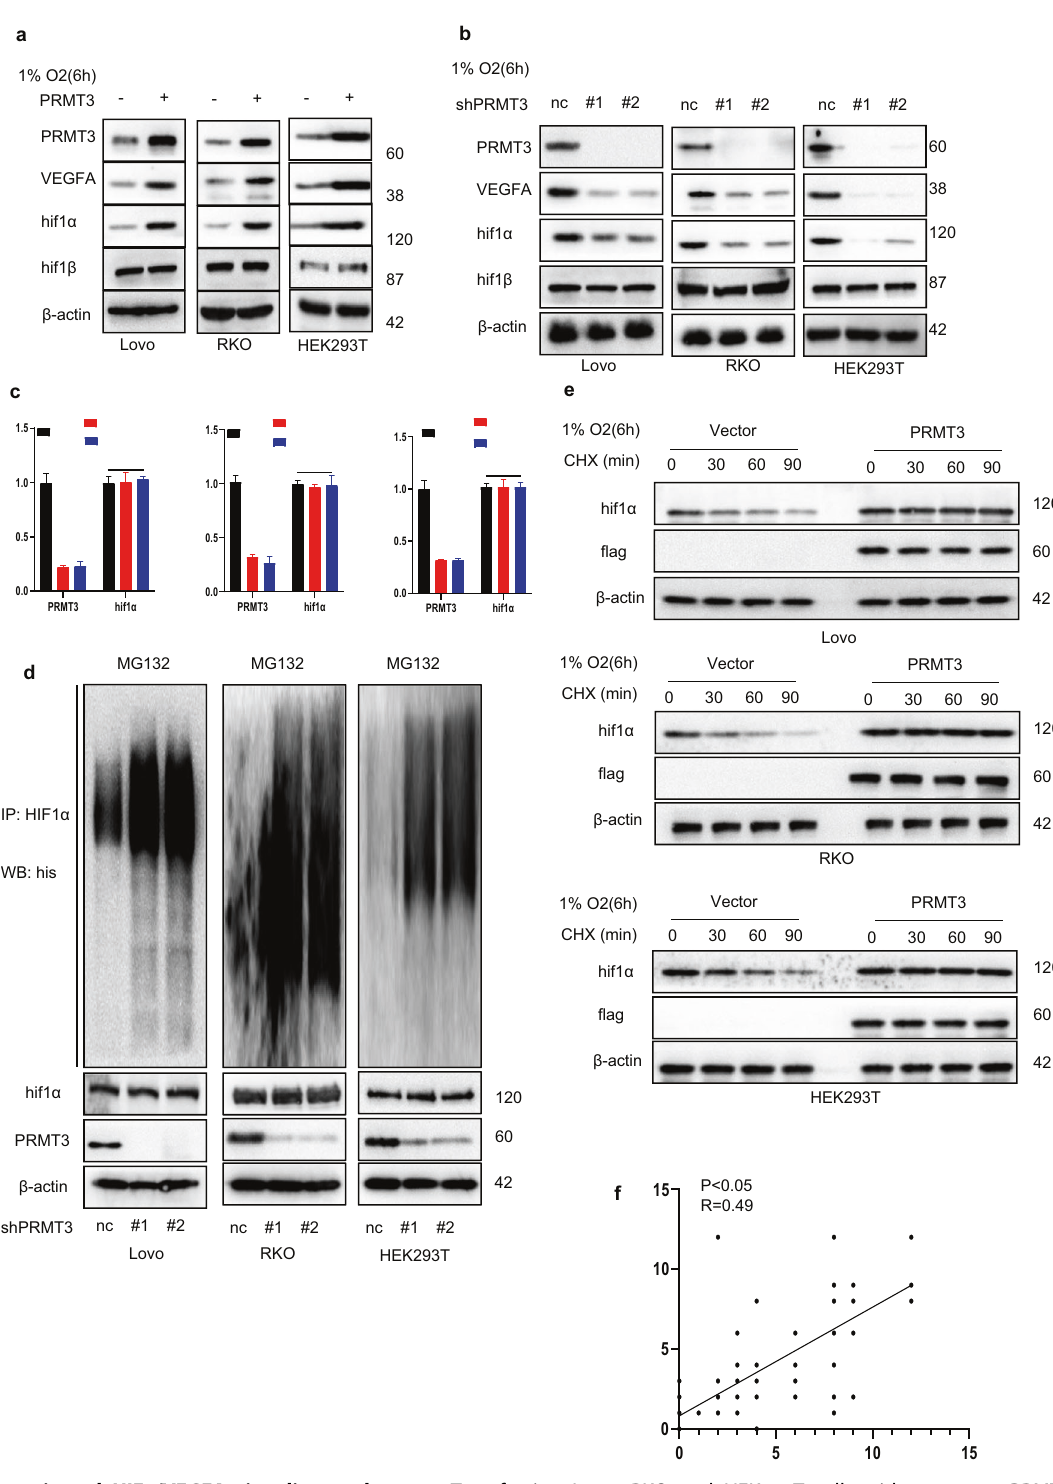
Fig. 3 PRMT3 activated HIF1/VEGFA signaling pathway. a Transfecting Lovo, RKO and HEK293T cells with vector or PRMT3 plasmid, immunoblots analysis to investigate identi fi ed proteins expression level in hypoxia. b Silencing PRMT3 expression in Lovo, RKO and HEK293T, immunoblots analysis to investigate identi fi ed proteins expression level in hypoxia. c silencing PRMT3 expression level of Lovo, RKO and HEK293T cells using lentivirus, mRNAs expression level of the indicated proteins. d Silencing PRMT3 expression level in Lovo, RKO and HEK293T cells using lentivirus, Transfection of his-ubiquitination plasmid into cells, MG132 to inhibit endogenous HIF1 α degradation; Isolating HIF1 α from identi fi ed cells and then immunoblots analysis to assess HIF1 α poly-ubiquitin level. e Cycloheximide (CHX) to inhibit